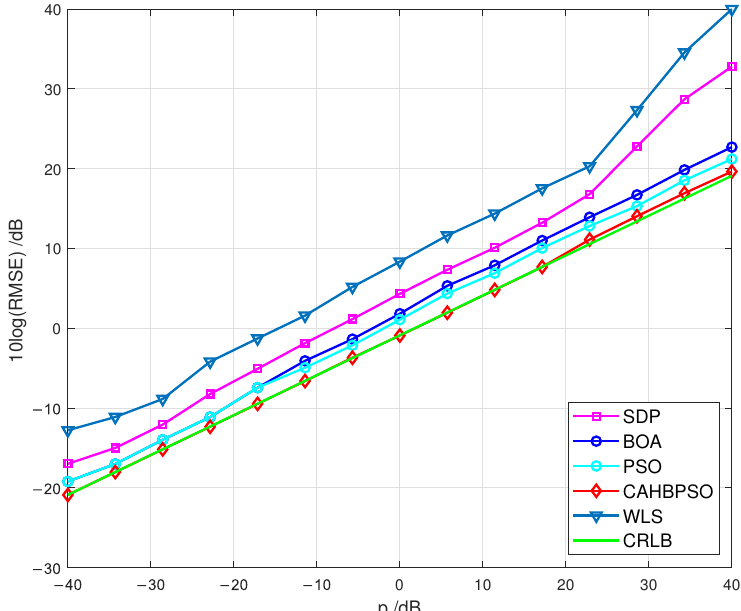
Figure 7. RMSEs in terms of p for a passive target at x = [ 100 80 ] T .